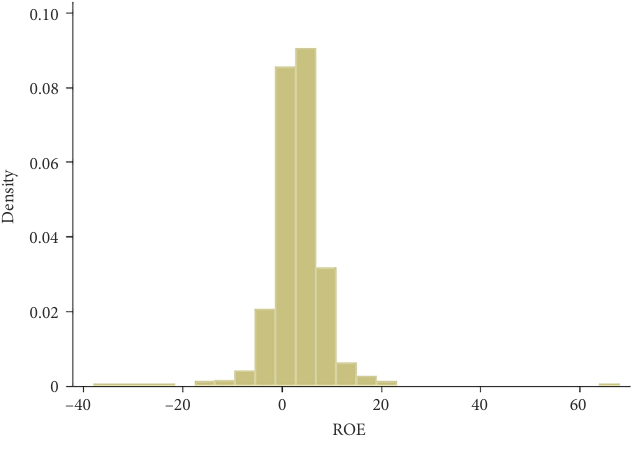
Figure 1. ROE histogram: SI